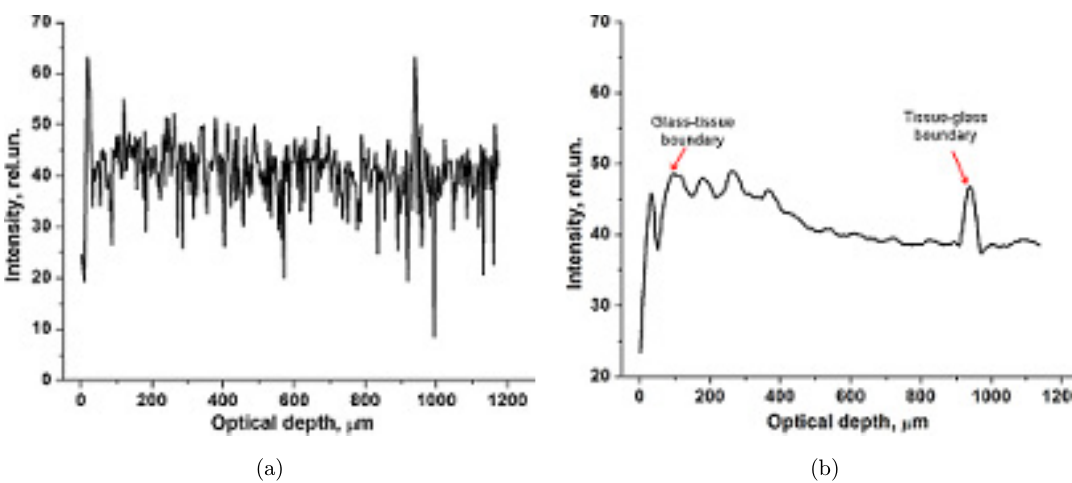
Fig. 4. Examples of A-scans: (a) individual; (b) averaged over the whole lateral interval seen in Fig. 2(b).